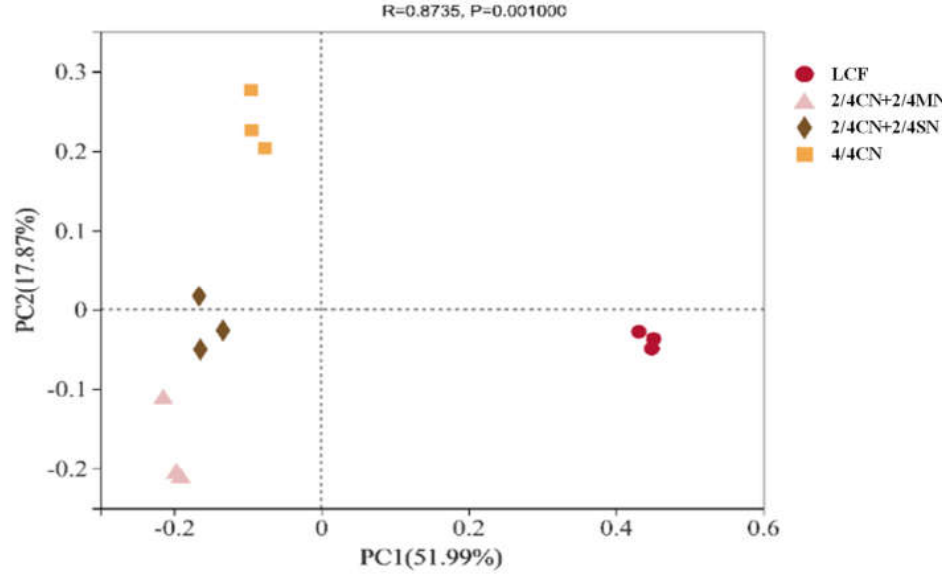
Figure 2. Principal coordinate analysis of bacterial community (genus) of all treatments. CN: chemical nitrogen; MN: swine manure nitrogen; SN: maize straw nitrogen; LCF: local conventional fertilization.